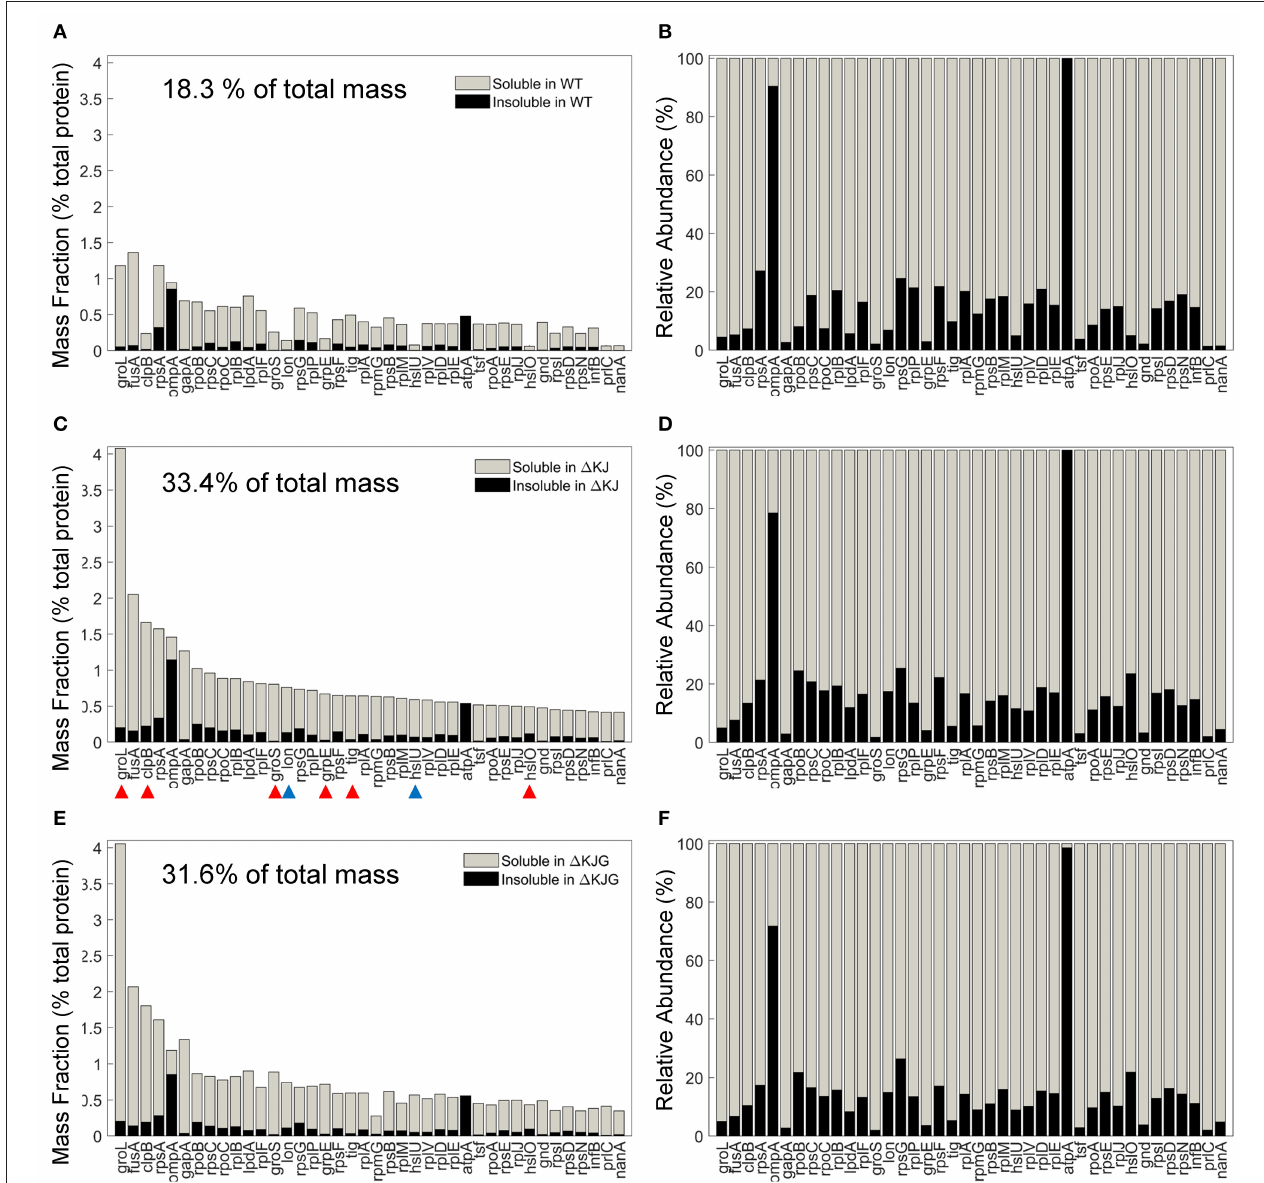
FIGURE 5 | Mild aggregation of the most abundant proteins significantly upregulated in 1 KJ. (A) Absolute abundances (mass fractions of the total cellular protein amount) in wild type (WT) soluble (gray bars) and insoluble (black bars) fractions for the 40 most abundant proteins of 1 KJ Escherichia coli that were significantly upregulated in 1 KJ compared to WT. (B) Normalized abundances in WT E. coli of the same proteins as in (A) . Red arrowheads: chaperones; blue arrowheads: proteases. (C) Absolute abundances (mass fractions) of the same proteins as in (A) , but showing their amounts in 1 KJ soluble (gray bars) and insoluble (black bars) fractions (D) Same as in (C) , with normalized abundances. (E) Absolute abundances (mass fractions) of the same proteins as in (A) , but showing their amounts in 1 KJG soluble (gray bars) and insoluble (black bars) fractions. (F) Same as in (E) , with normalized